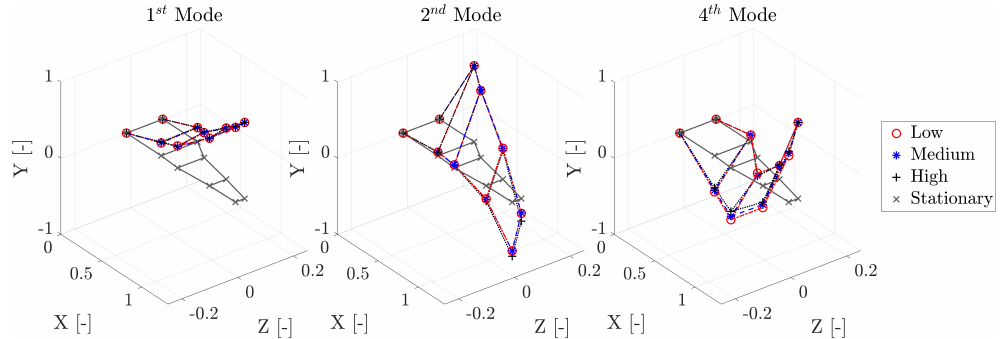
Figure 22. Full wing: mode shapes of the first three vertically dominant